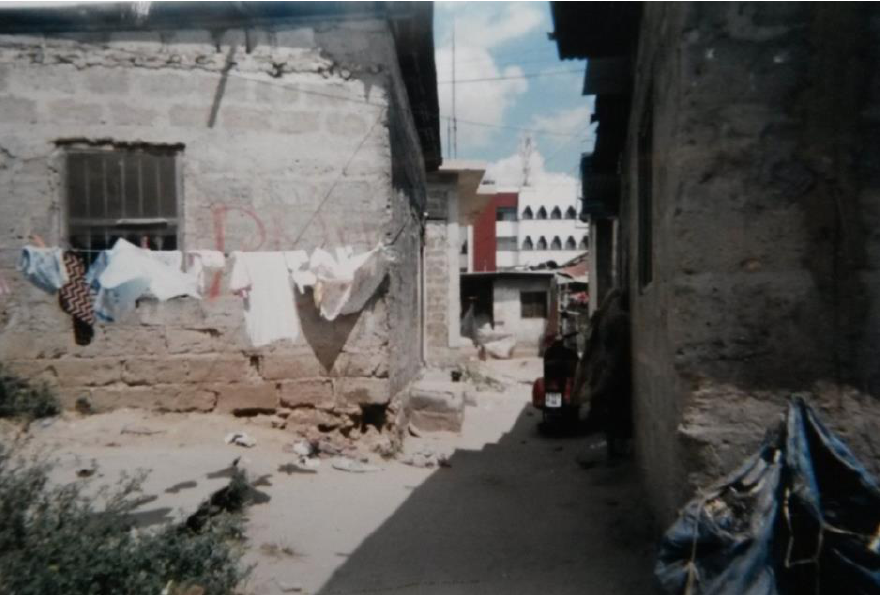
Figure 7. ‘The madrasas [ vyuo ] are very old/bad [ vibovu ] and in one madrasa there are so many people. So now we ask that you can help us build [ mututengenezee ] ’ . (Arif, 12 years old)